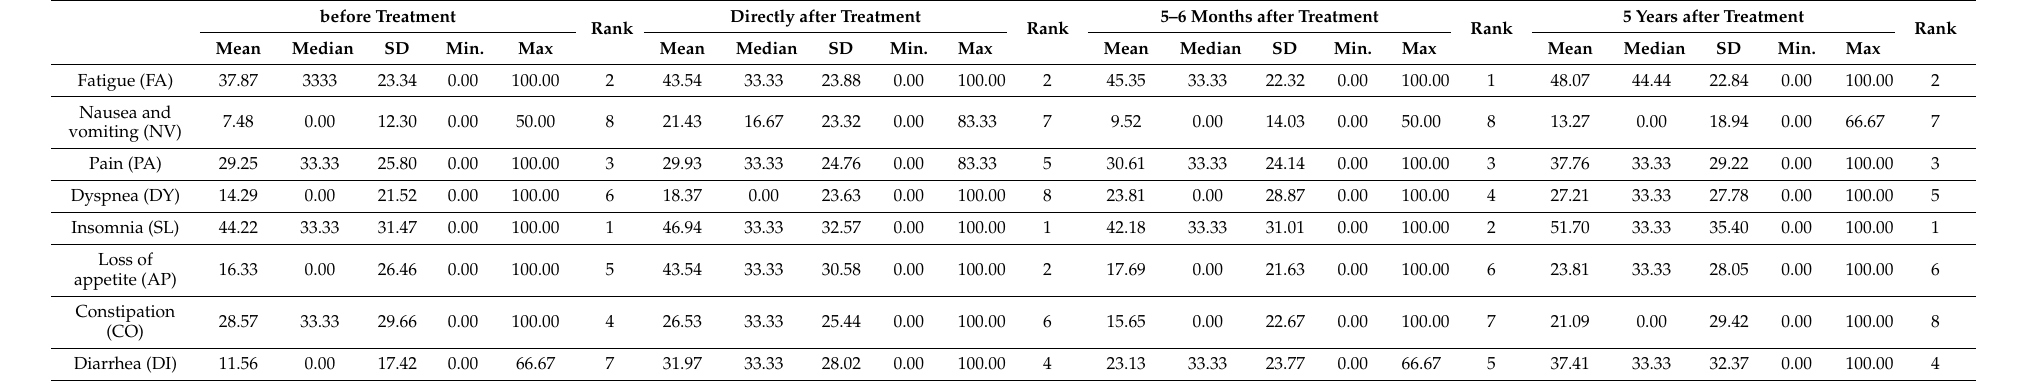
Table 6. Mean somatic subscale values with rank